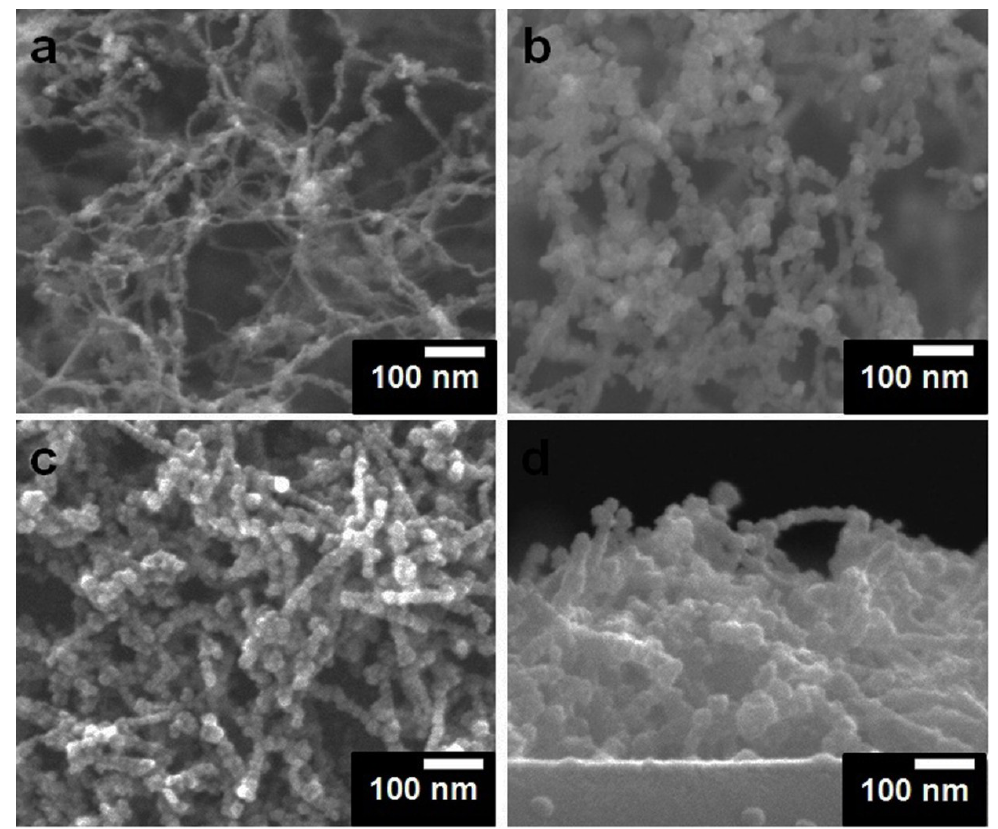
/SWCNT; ( c ) PAA/SnO 2